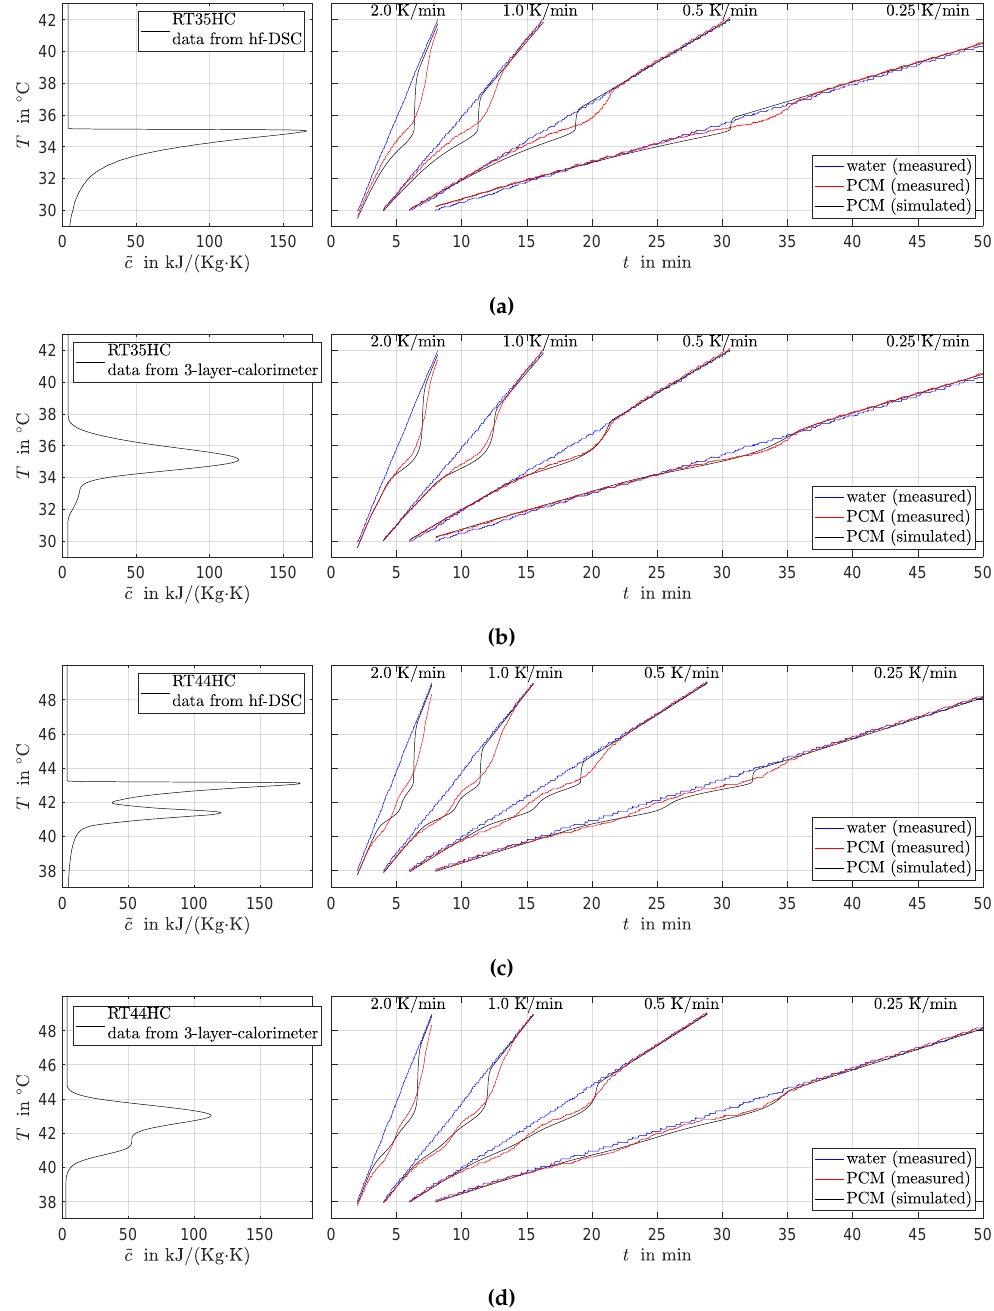
Figure 9. Comparison of measured (exp.) and predicted (sim.) PCM temperatures in the HEX filled with RT35HC ( a , b ) and RT44HC ( c , d ) for different heating experiments where the water temperature is increased at different rates with 0.25 K/min, 0.5 K/min, 1.0 K/min, 2.0 K/min. Apparent specific heat capacities are taken from Figure